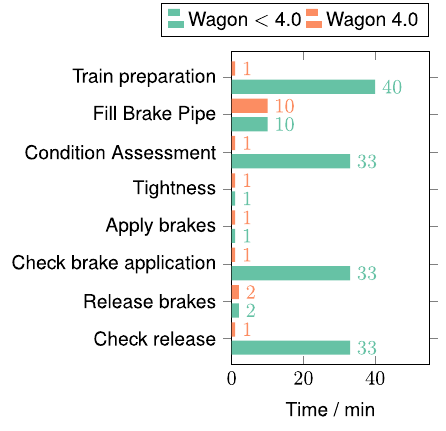
Fig. 8 Time consumed for the individual steps of brake tests, exist- ing fleet (Wagon < 40) compared to Wagon